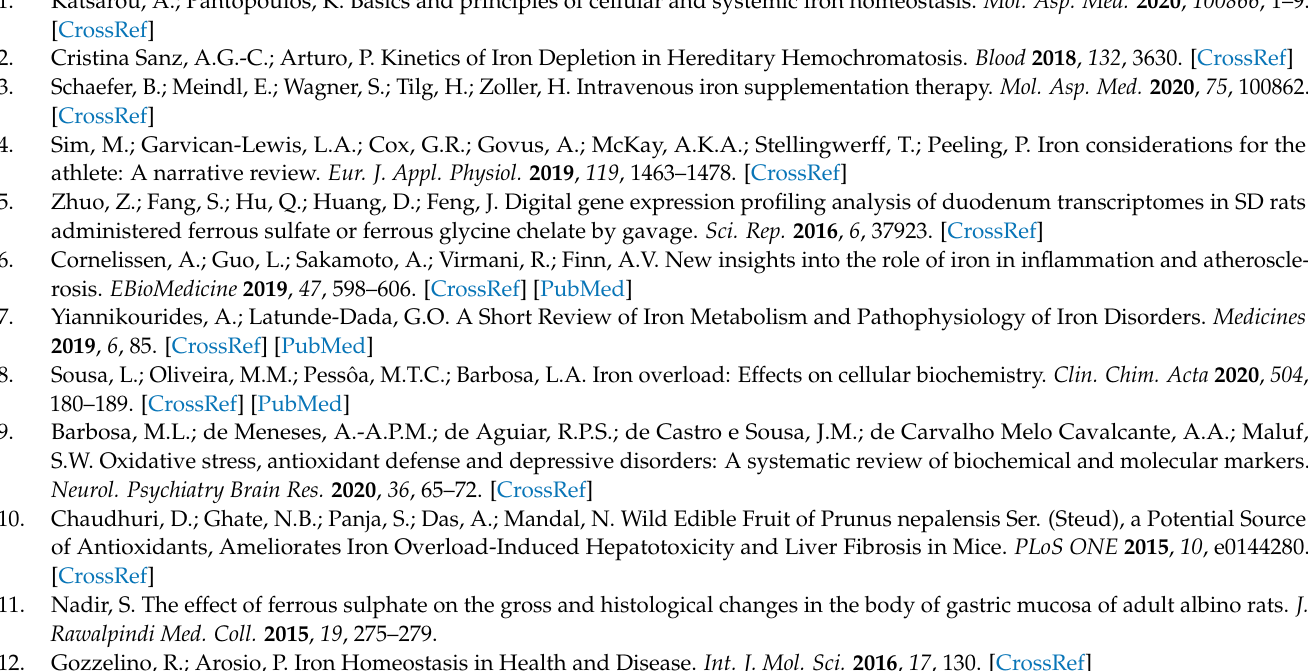
Table S2. p -Values of Pearson’s correlation